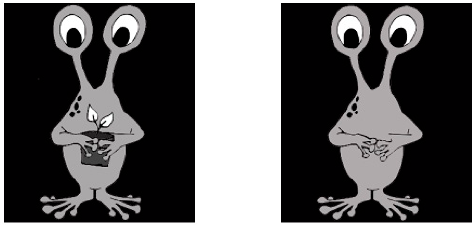
Figure 1. Example of alien stimuli used in the irrelevant task. In this example, the alien is seen holding a plant pot or not holding a plant pot.